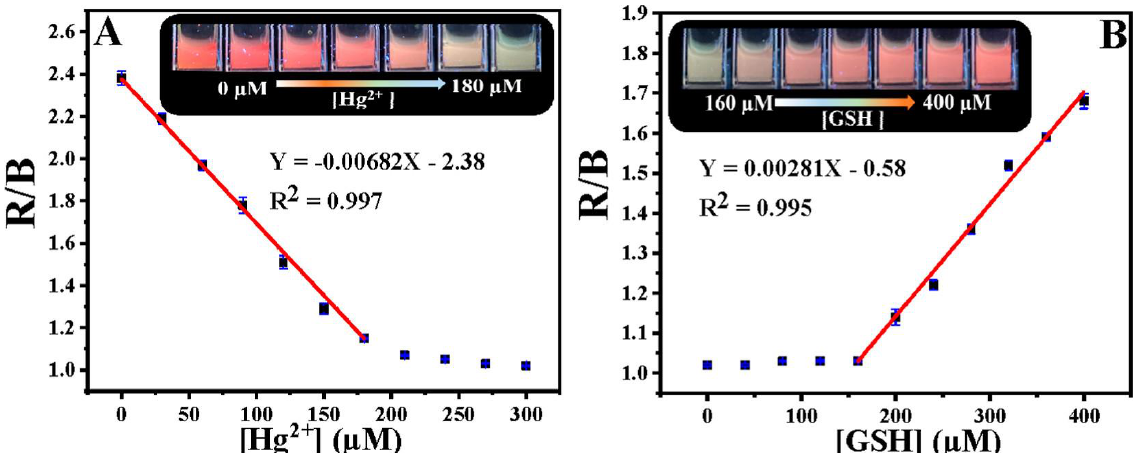
Figure 6. ( A ) R/B values as a function of Hg 2+ concentrations. Inset: Fluorescent color of NSCDs with different concentrations of Hg 2+ (0 –180 μM) under a 365 nm UV lamp. ( B ) R/B values as a function of GSH concentrations. Inset: Fluorescent color of NSCD – Hg 2+ with different concentrations of GSH (160 –400 μM) under a 365 nm UV lamp ( ( A , B ) is reproduced with the permission from Ref. [106]). Table 2. Linear ranges, LODs, suitable assay pH, and applications of fluorescent biothiols assay by CD – Hg 2+ ion pair.